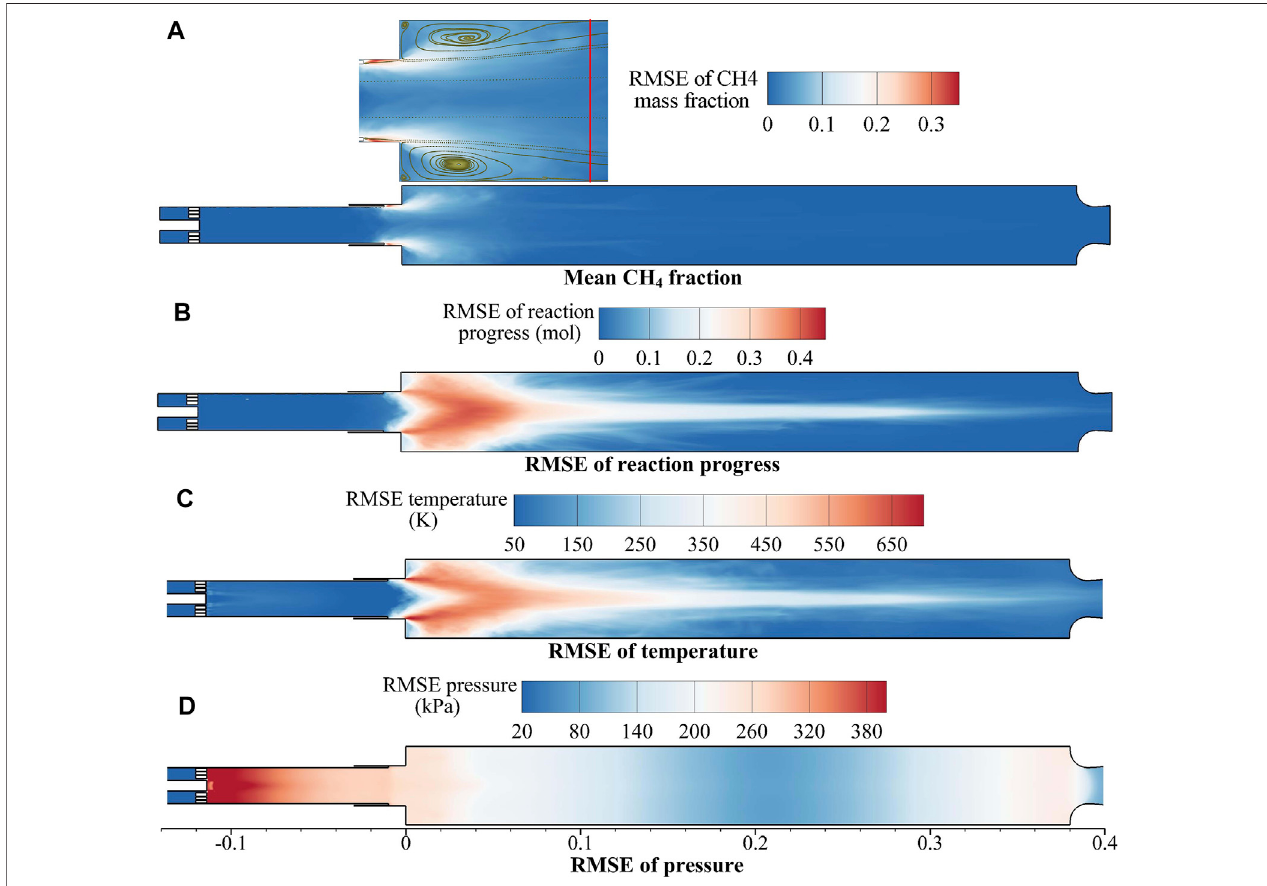
FIGURE 13 | RMSE fl ow fi elds (A) mass fraction of CH 4 , (B) reaction progress, (C) temperature, and (D)